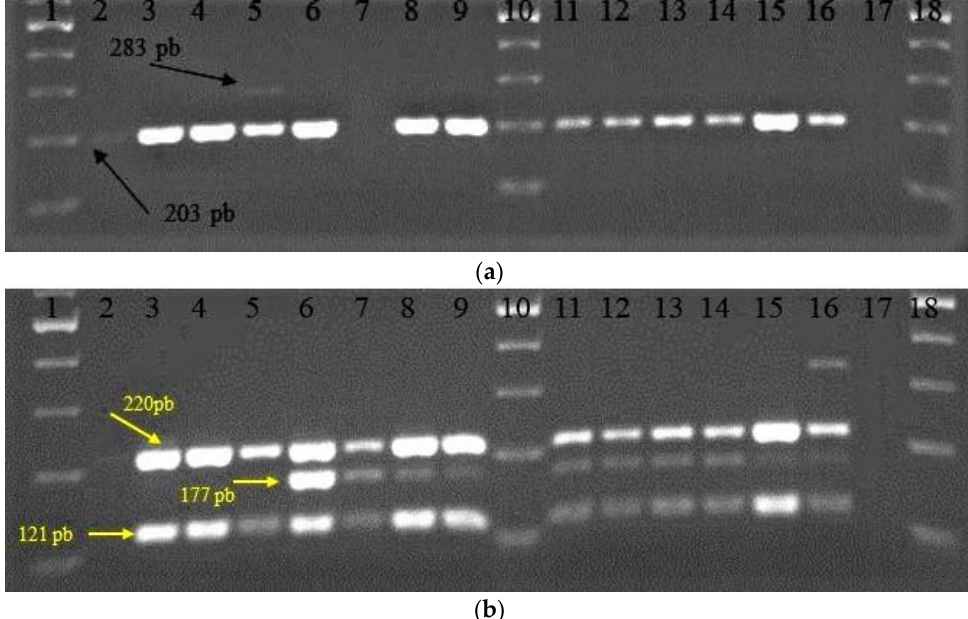
Figure 3. Electrophoretic pattern for multiplex PCR: ( a ) LBA1272 , 203 pb (black arrow) and dltD , 283 pb (black arrow); ( b ) α -amy , 220 pb (yellow arrow); malL , 177 pb (yellow arrow); and ribA , 121 pb (yellow arrow). Samples: 1,10,18—ladder 100 pb, 2—L22, 3—L26, 4—L35, 5—LAB43, 6—L58, 7—L61, 8—BR9, 9—CR1, 11—Fv52, 12—Fv177, 13—P124, 14—ST111, 15—26.1, 16—34.9, 17—no